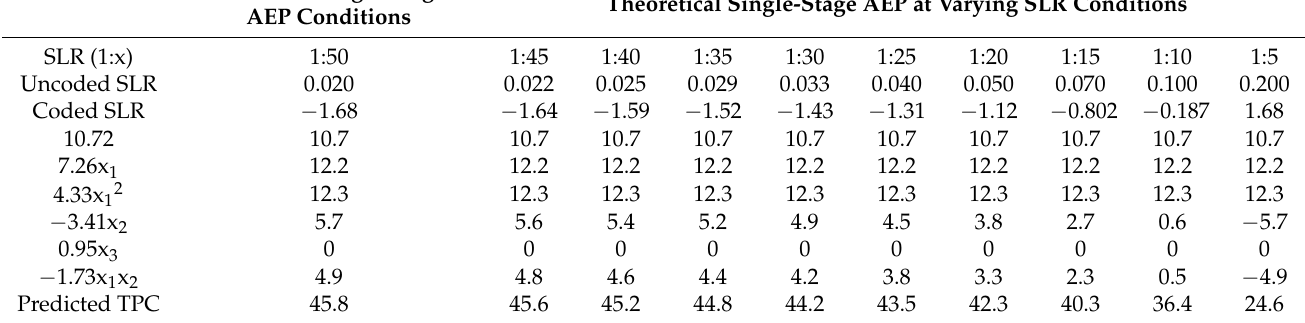
Table 1. Effect of increasing the slurry SLR on the predicted TPC of aqueous extracts produced by the single-stage